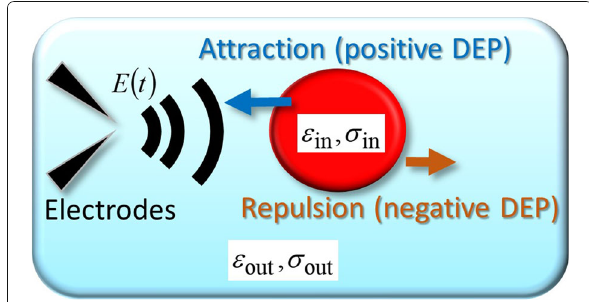
Fig. 3 Theoretical model. Schematic representation of the FM-DEP force exerted on a cell that is modelled as a homogeneous sphere model having the permittivity and conductivity of (cid:5) in and σ in , respectively. The sphere is surrounded by electrolyte medium with its permittivity and conductivity of (cid:5) out and σ out , respectively. The homogeneous sphere model is the simplification of the spherical single shell model that regards the cell as a smeared-out cytoplasm surrounded by a membrane